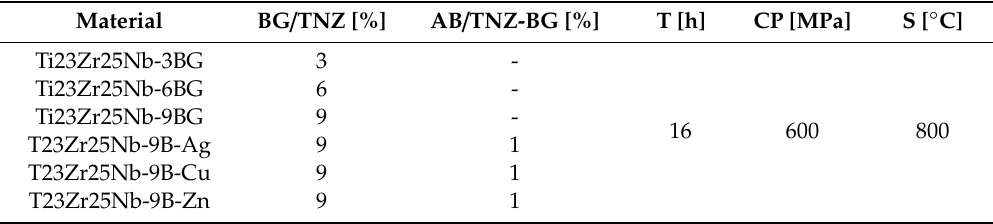
Table 1. The mass ratios of output precursors and optimization parameters for preparation of